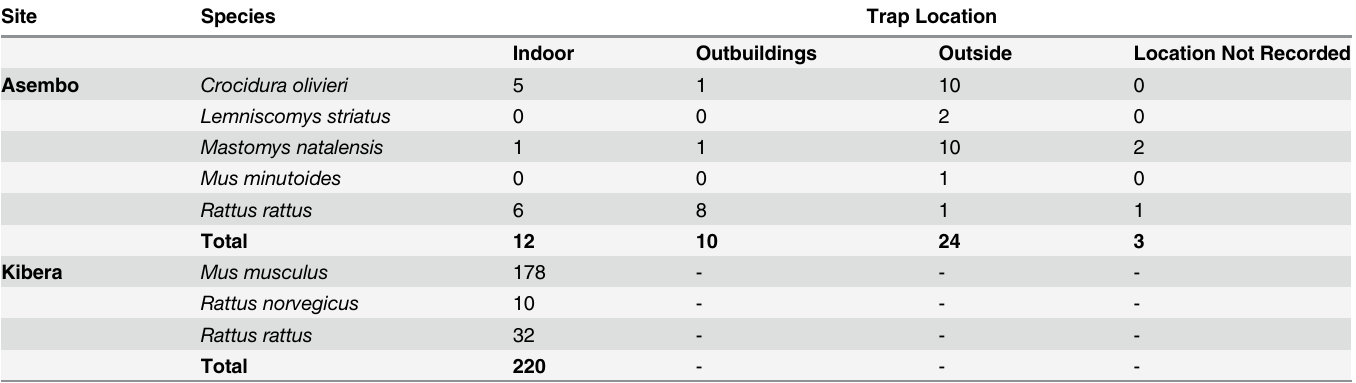
Bartonella species are shown in Figs 3 and 4. Bartonella detected in one M . natalensis and two R . rattus trapped in Asembo belong to the B . elizabethae species complex based on the similari- ty of the gltA sequences (Fig. 3 & Table 2). Five additional sequences detected in M . natalensis and one detected in L . striatus were most closely related to B . tribocorum . None of the strains obtained from M . natalensis or L . striatus were identical ( (cid:3) 96% sequence identity) to reference strains of the Bartonella species described previously in Rattus species trapped elsewhere. The strain of Bartonella cultured from a C . olivieri was not very similar to any previously described species ( B . elizabethae , B . tribocorum and B . queenslandensis ) were detected in the two Rattus dents were identical ( (cid:3) 96% sequence identity) to reference isolates that are typical of Barto-